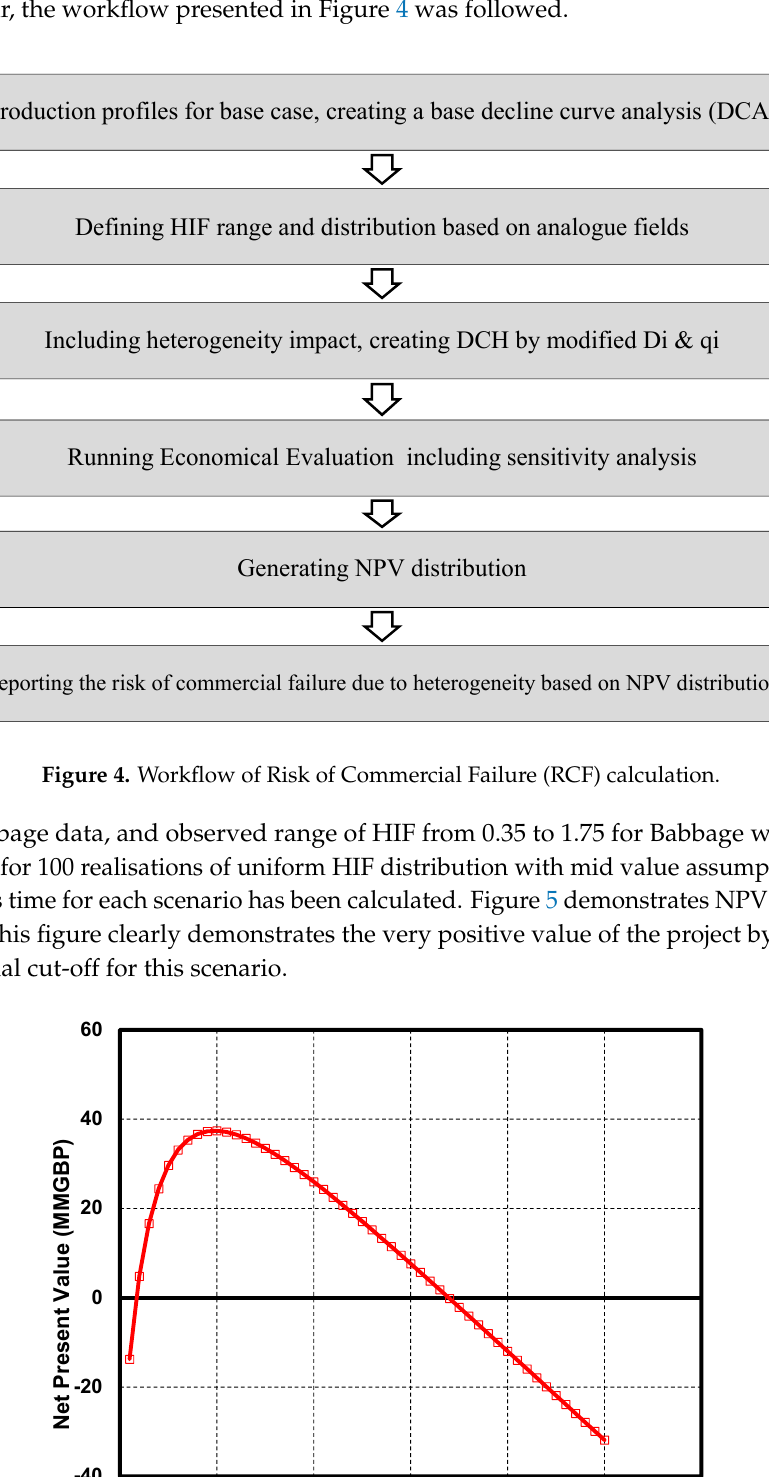
Figure 5. NPV versus production time for base case (HIF = 1).